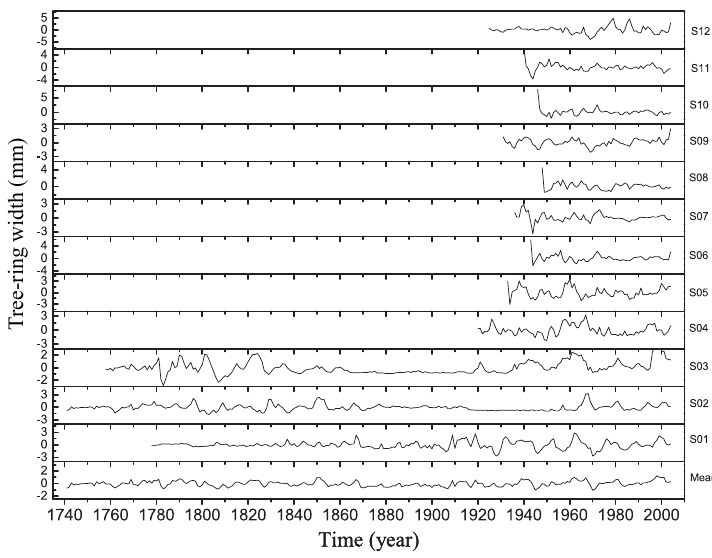
Figure 1. Mean time series of growth ring thickness of trees from Passo Fundo, Rio Grande do Sul, after removing their long trend curves.